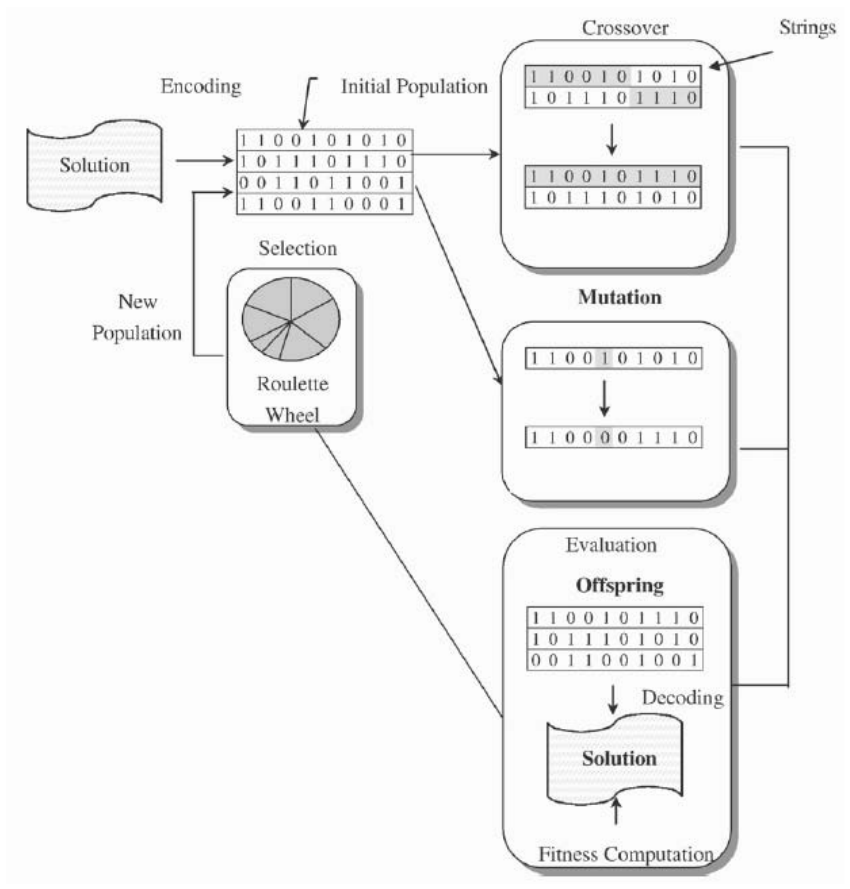
Figure 2. The fundamental cycle and operations of basic GAs (Gen and Cheng,